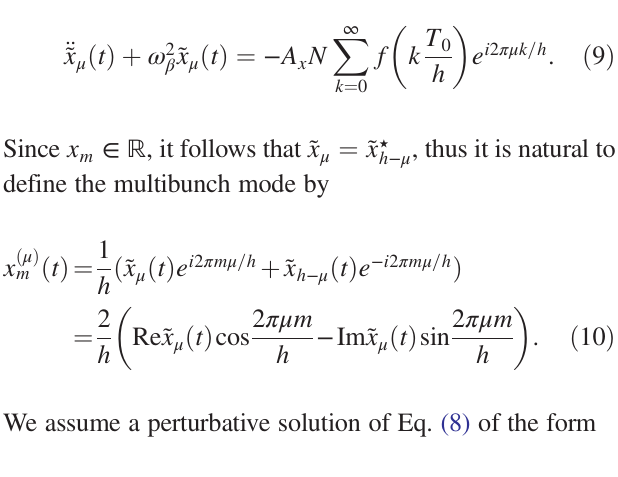
TABLE II. Parameters for the NSLS-II 3DWs